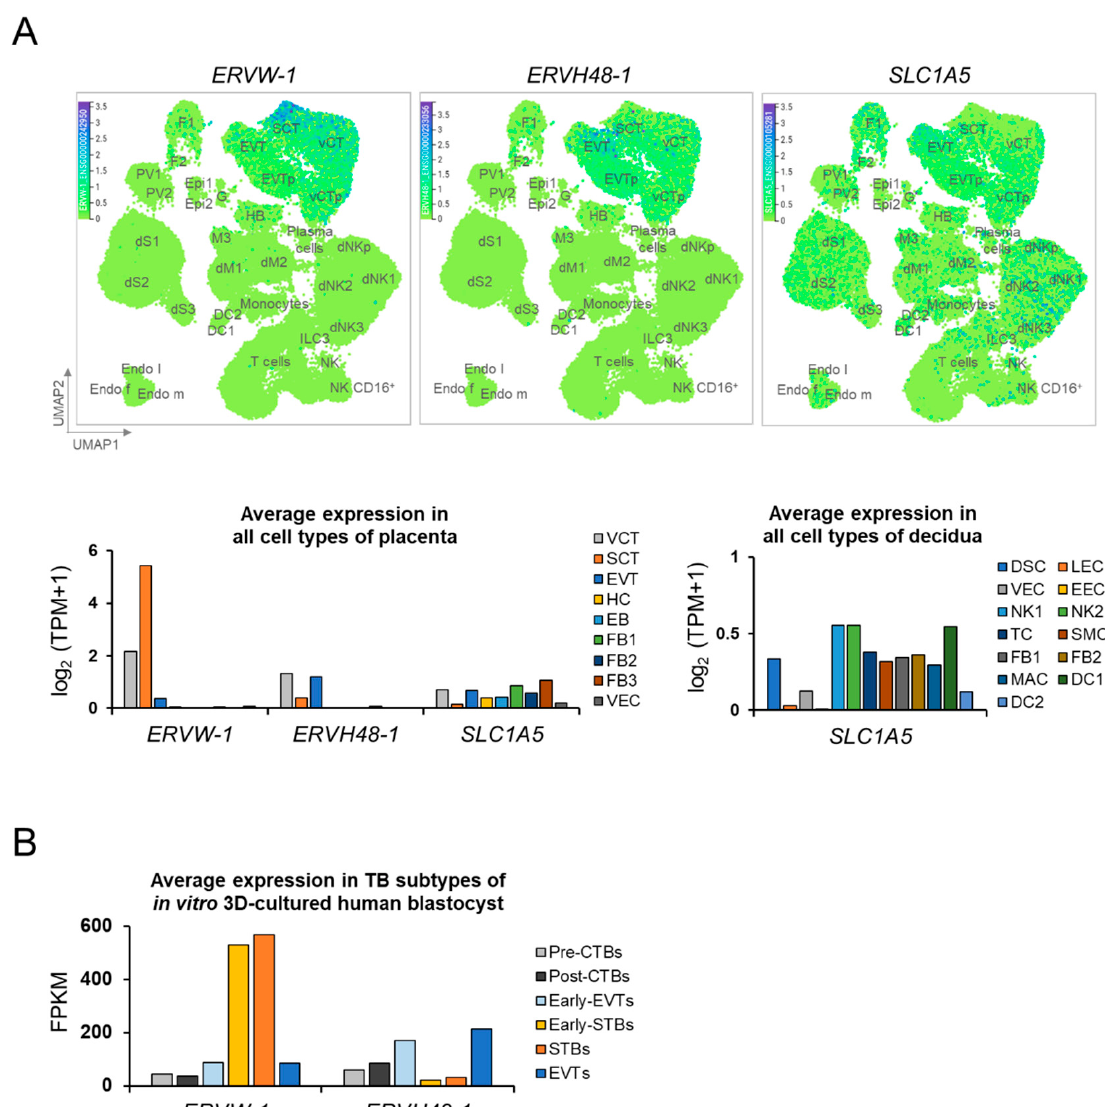
Figure 2. In silico analysis of Syncytin-1 ( ERVW-1 ), SUPYN ( ERVH48-1 ), and/or SLC1A5 /ASCT2 expression in the human first-trimester placenta/decidua and in the TB subtypes of extended 3D human blastocyst cultures. ( A , upper) UMAP visualization of the log-transformed, normalized expression levels in placental and decidual cell clusters of the first trimester (6 to 14 weeks of gestation; placenta, n = 5; decidua, n = 11; blood, n = 6). Data are taken from a publicly available datasets found online at http://data.teichlab.org (maternal-fetal interface) provided by Vento-Tormo et al. (accessed on 14 November 2018) [21]. A graph-based clustering analysis was applied for distinct cell clusters and cluster-specific marker genes were used to annotate the clusters. DC, dendritic cells; dM, decidual macrophages; dS, decidual stromal cells; Endo, endothelial cells; Epi, epithelial glandular cells; F, fibroblasts; HB, Hofbauer cells; PV, perivascular cells; SCT, syncytiotrophoblast; VCT, villous cytotrophoblast; EVT, extravillous trophoblast; f, fetal; ILC, innate lymphocyte cells; l, lymphatic; m, maternal; p, proliferative; M3, maternal macrophages; G, granulocytes. ( A , lower) Average transcript expression in all cell types derived from placenta and decidua of the first trimester (6 to 11 weeks of gestation; villi, n = 8; decidua, n = 6). scRNAseq data